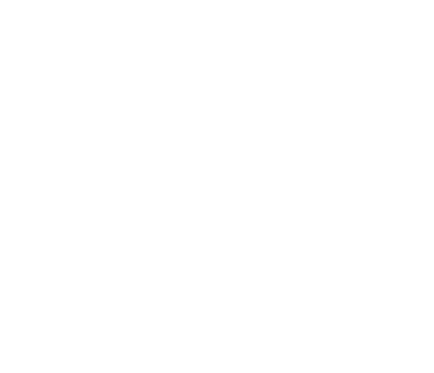
Table 7. Statistical parameters of the fitting